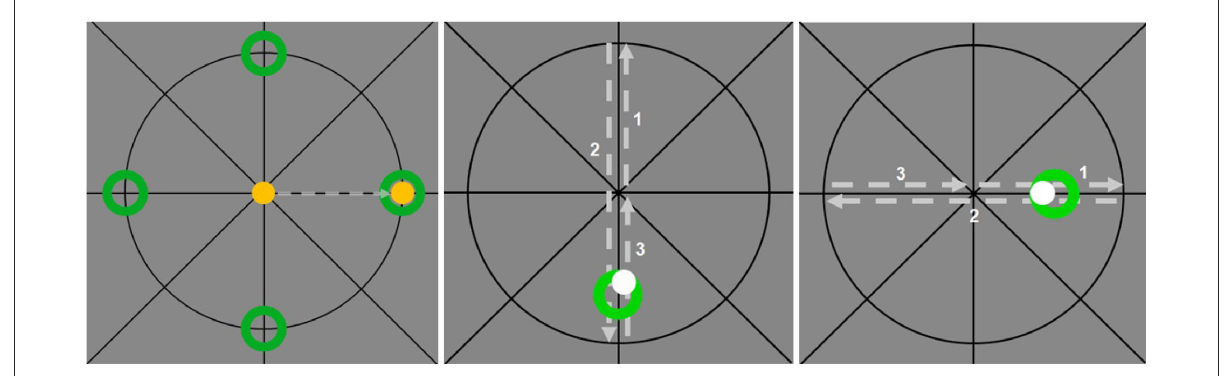
FIGURE2 Experimental tasks. Aiming (left) : The four green target positions and the circular cursor (yellow) at the starting point and the target position. Tracking: The green target ring and the cursor (gray) during vertical tracking (middle) and horizontal tracking (right) .